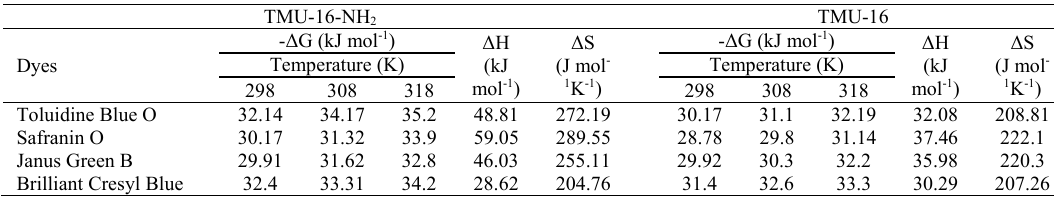
Table 5: Adsorption thermodynamics functions of dyes over TMU-16 and TMU-16-NH 2 . TMU-16-NH 2 Dyes